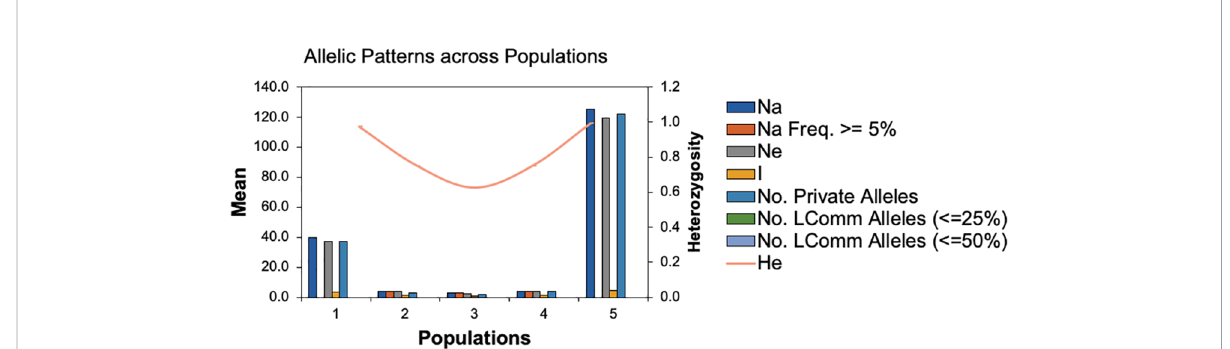
FIGURE 3 Patterns of allele frequency across populations. Na; no. of different alleles, Na (Freq >= 5%); No. of different alleles with a frequency >= 5%, Ne= No. of effective alleles, I; Shannon ’ s Information Index, No. LComm Alleles (<=25%); No. of Locally Common Alleles (Freq. >= 5%), No. LComm Alleles (<=50%); No. of Locally Common Alleles (Freq. >= 5%), He, Expected Heterozygosity; uHe, Unbiased Expected Heterozygosity.